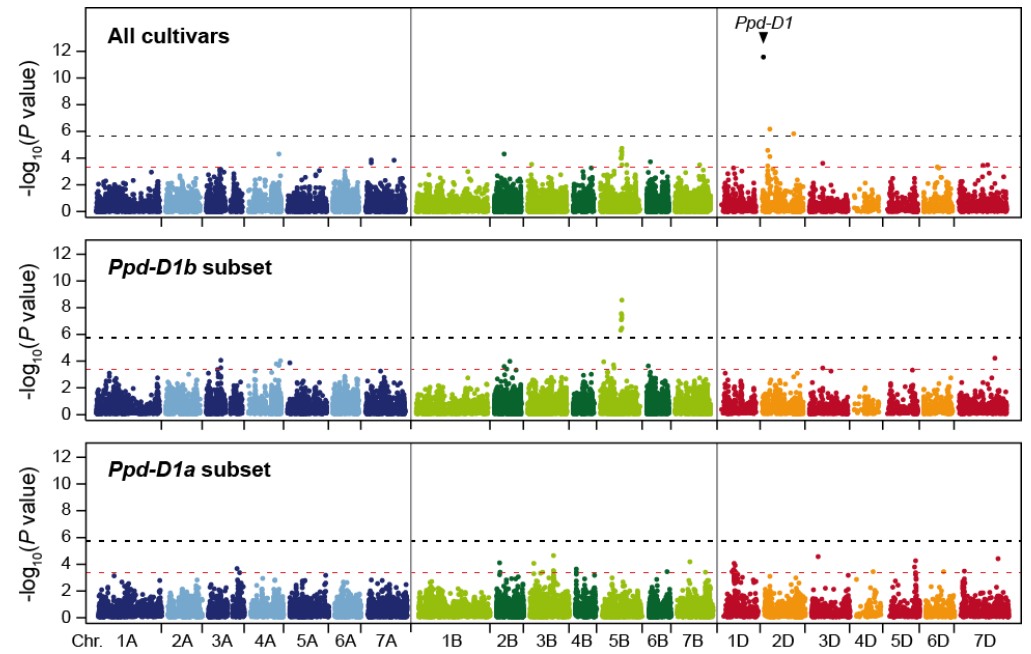
Figure 3. Manhattan plots showing the results from the genome-wide scan for cereal leaf beetle resistance in the entire panel, as well as in the Ppd-D1b (photoperiod sensitive) and Ppd-D1a (photoperiod insensitive) subsets. The black dashed horizontal line indicates the significance threshold (Bonferroni-corrected p < 0.05), and the red dashed horizontal line the exploratory significance threshold ( p < 0.0005). Table 1. Markers identified as significantly associated with cereal leaf beetle susceptibility in wheat. Gene / Marker Chr. Pos. (cM) Pos. (bp) a P Value p G E ff ect p b Ppd-D1